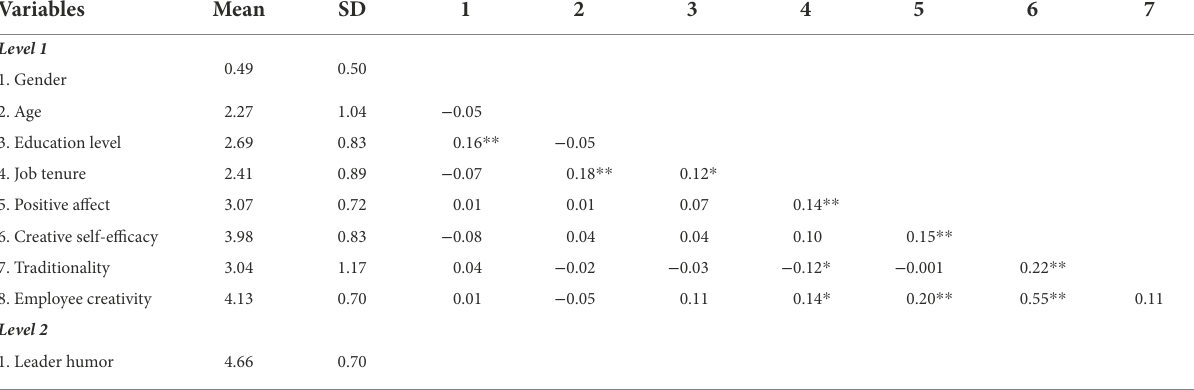
TABLE 3 Results of descriptive statistical analysis and coefficients of